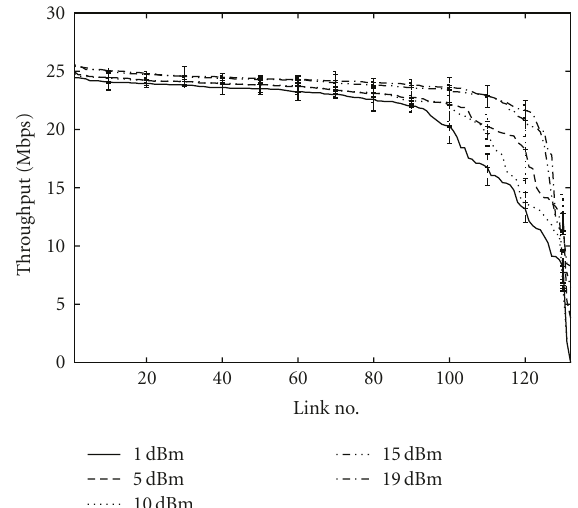
Figure 7: Impact of the transmission power on the connectivity of the 802.11g